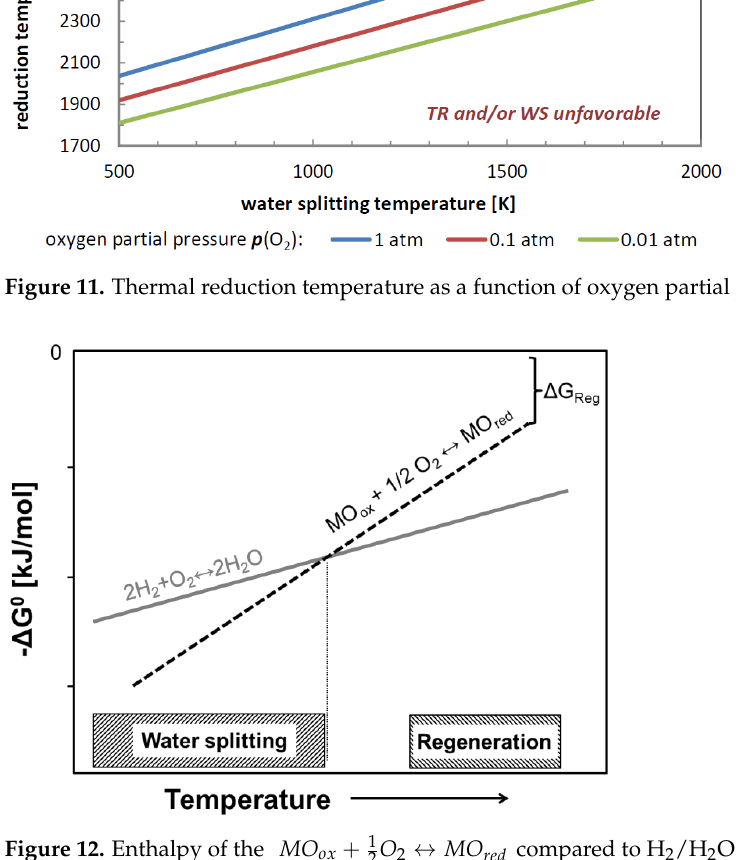
Figure 12. Enthalpy of the MO ox + 1